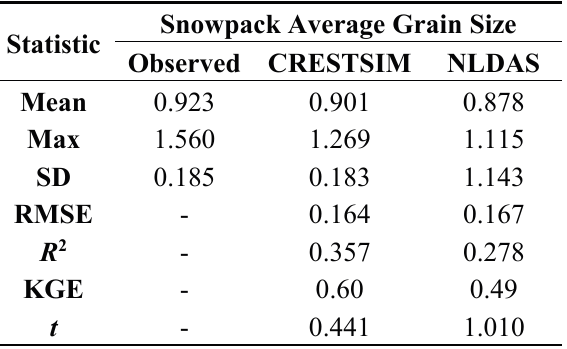
Table 6. Grain size statistics. Validation period: Winter 2011–2012. Row definitions are same as in Table 3. The number of observations was 29.